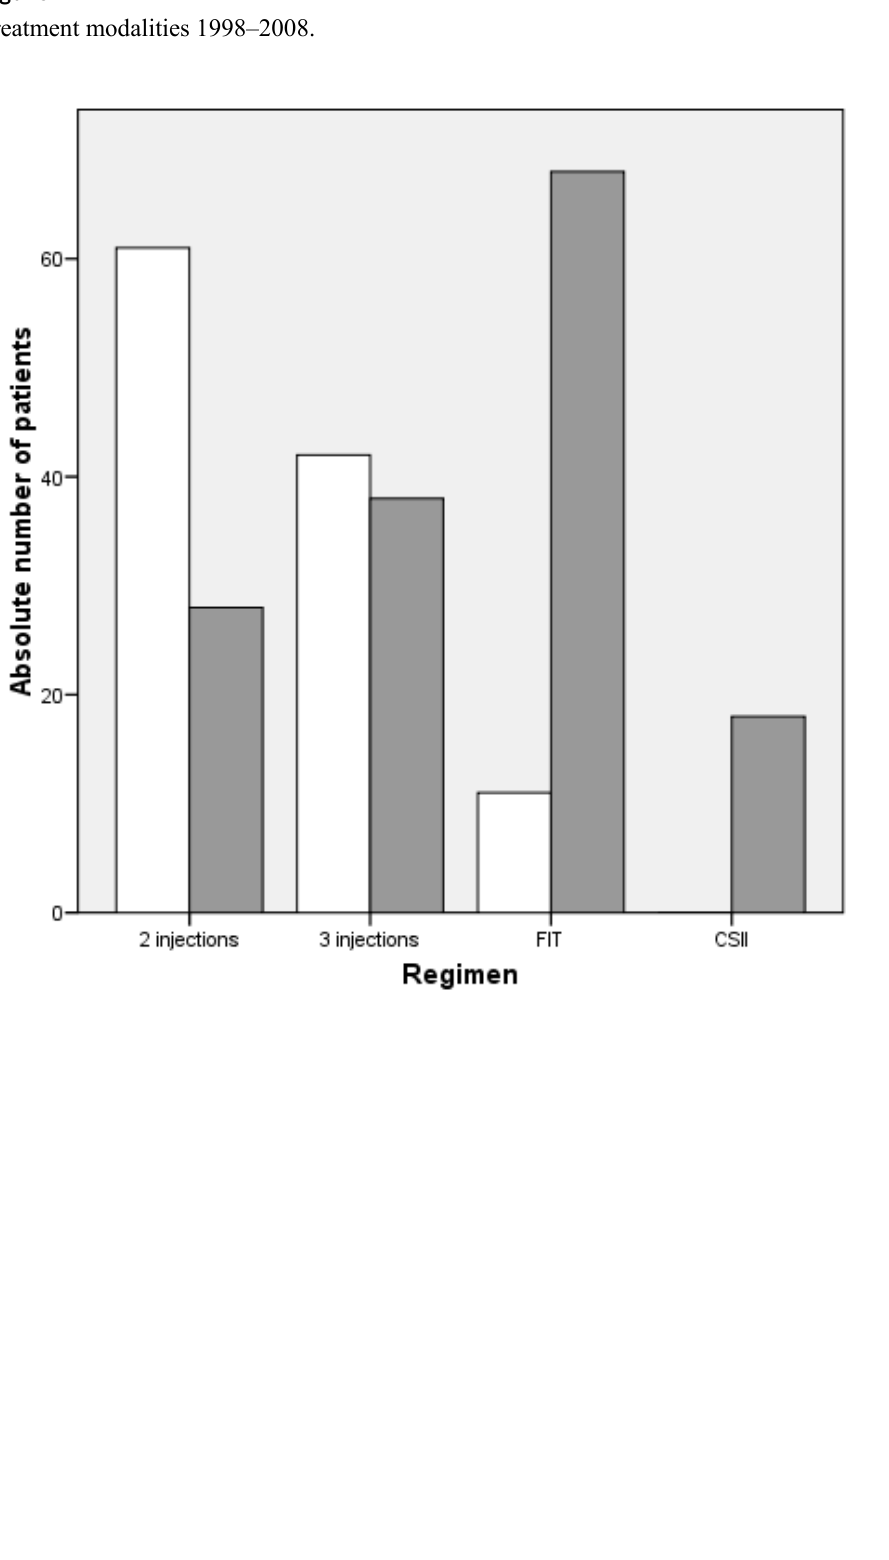
Treatment modalities